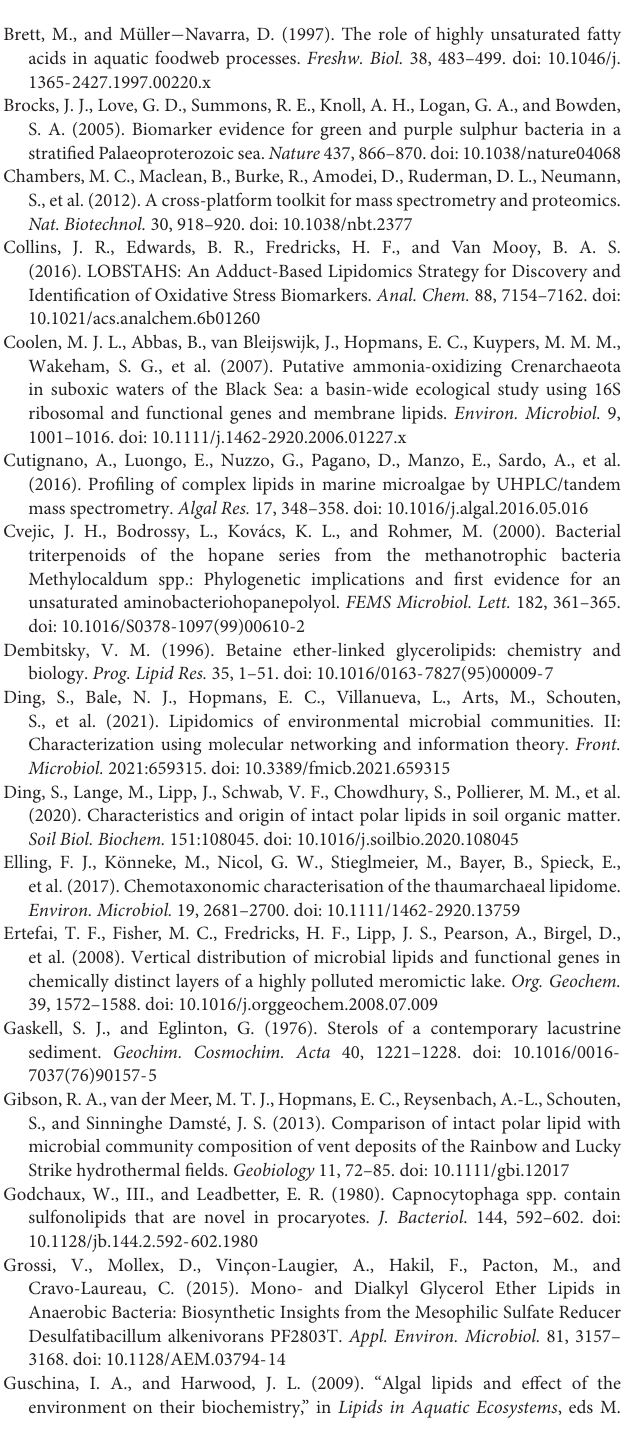
Supplementary Figure 1 | UHPLC-HRMS/MS spectra of unassigned components (A) I, (B) II, (C) III, and (D) IV. Mmu, milli mass unit. (cid:49) mmu = (measured mass − calculated mass) × 1000. Supplementary Figure 2 | Partial MS 1 spectra of double charged components listed in Table 3